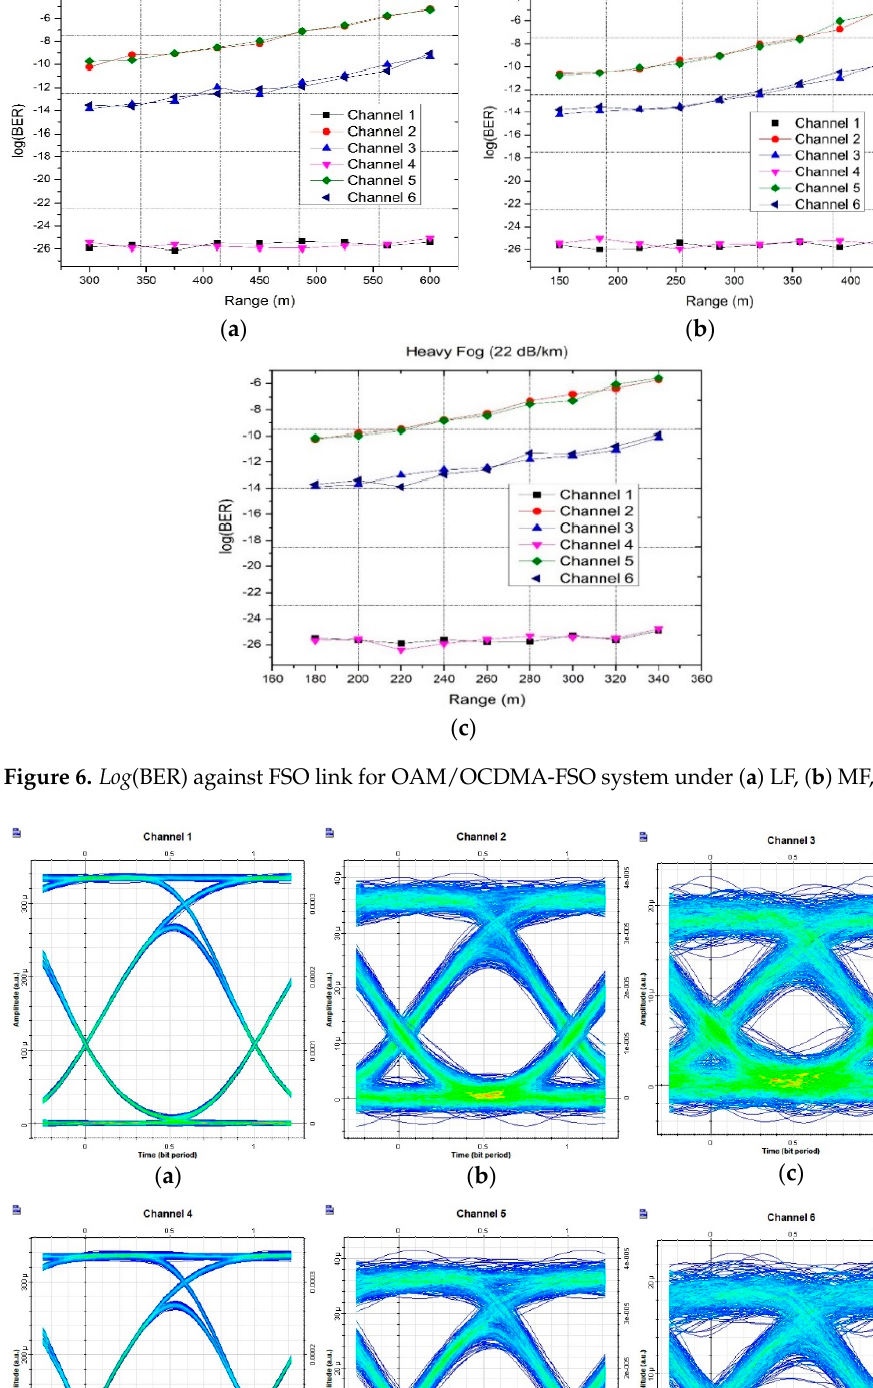
Figure 7. Eye diagrams for ( a ) channel #1, ( b ) channel #2, ( c ) channel #3, ( d ) channel #4, ( e ) channel #5, and ( f ) channel #6 under LF at 600 m FSO range.